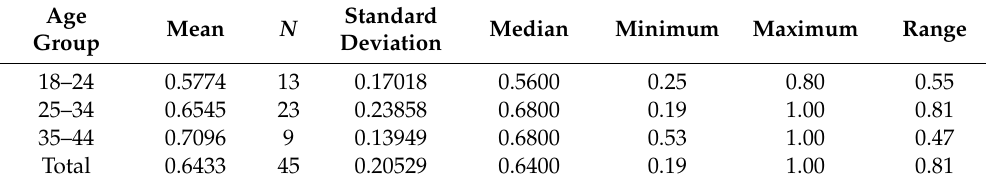
Table 18. Mean internal characteristic validity measure by age group.